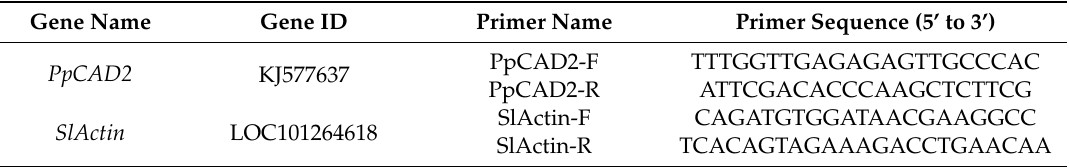
Table 1. Primers used for the q-PCR